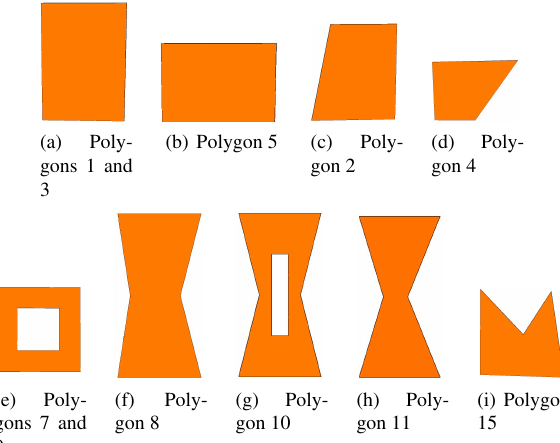
Figure 10: 3D planar polygons used in the test. Some polygons are of the same shape but at different locations of the